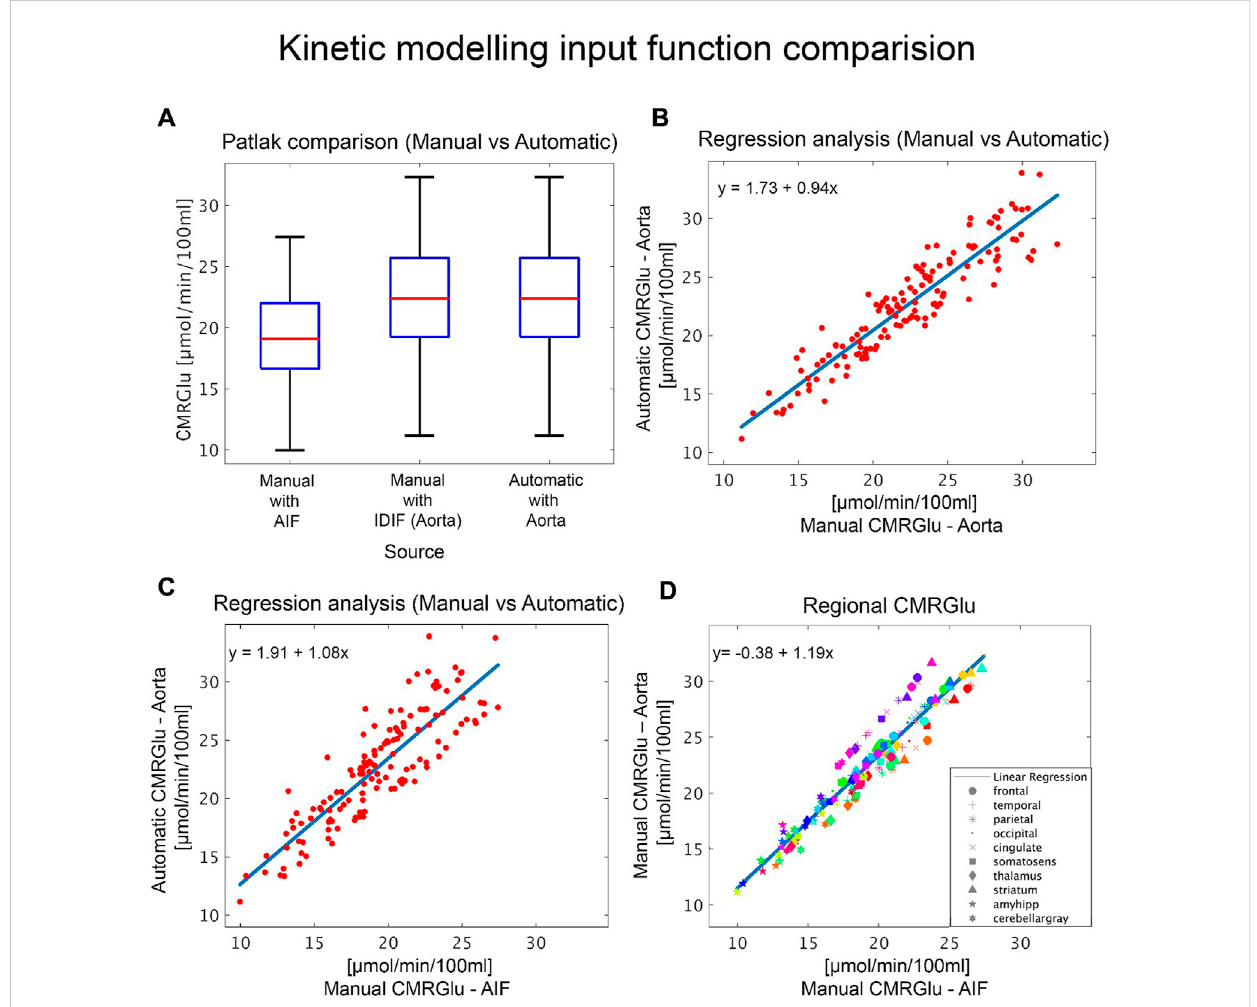
FIGURE 5 Comparison of kinetic modelling outputs: Quanti fi cation of glucose metabolism with different input functions. (A) Boxplots show overall cerebral metabolic rate of glucose (CMRGlu) values for the different input functions modelled either manually or automatically via the vendor software. (B – C) Regression analyses comparing CMRGlu obtained from the automatically generated aorta IDIF with (B) those from the manual aorta IDIF de fi nition, modelling and motion correction (P4) and (C) the AIF. Subplot (B – C) plots include values across all regions and subjects. (D) Regional CMRGlu uptake comparison between the AIF and IDIF(Aorta). Here the different colors represent each participant, and each symbol represents the regions of interest, listed in the legend.